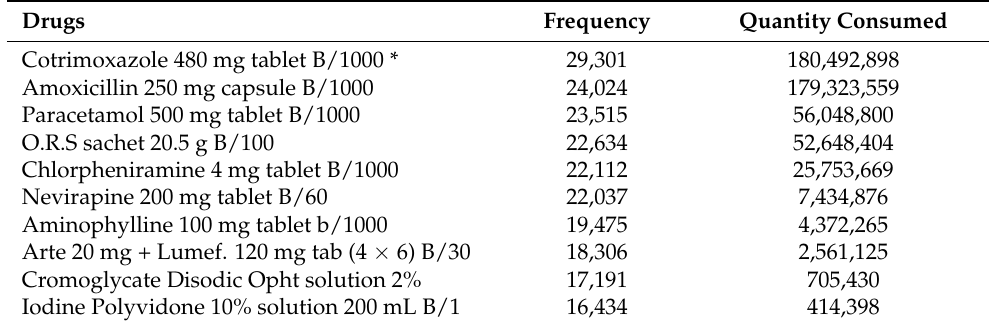
Table 2. Essential medicines consumed by frequency